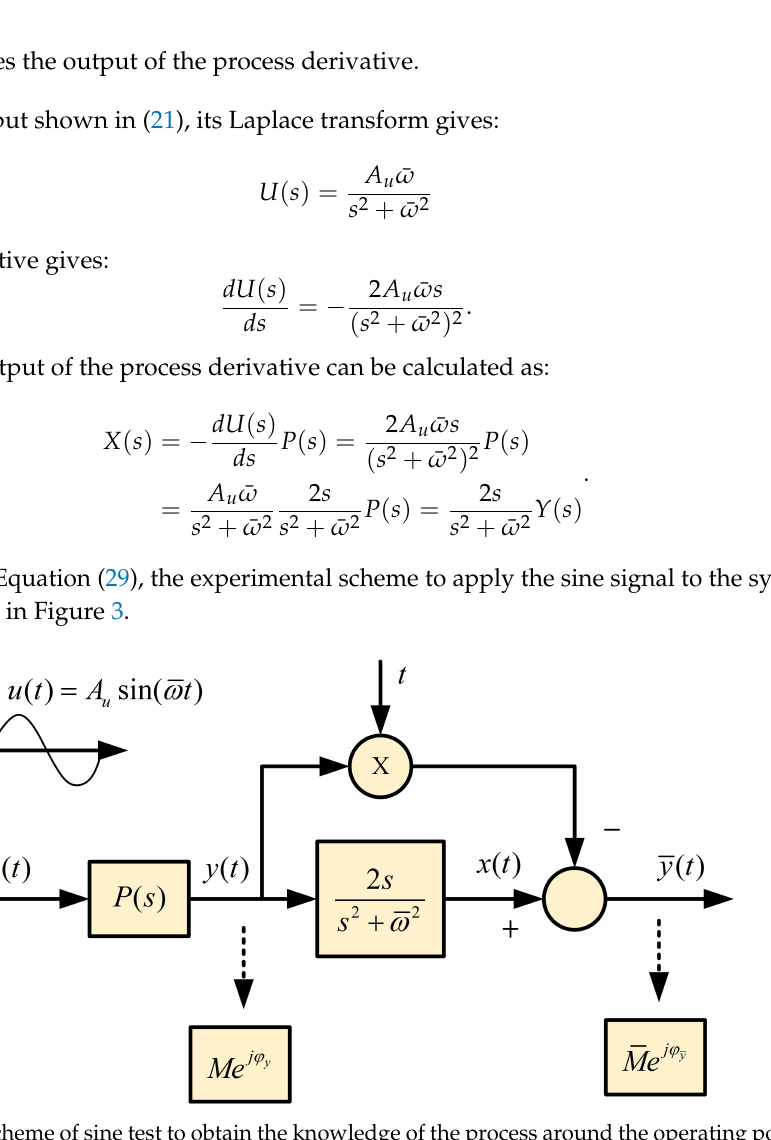
Figure 3. The scheme of sine test to obtain the knowledge of the process around the operating point [39] (reproduced with permission from De Keyser, R., Muresan, C. I. and Ionescu, C. M. A novel auto-tuning method for fractional order PI/PD controllers. ISA transactions, published by Elsevier,